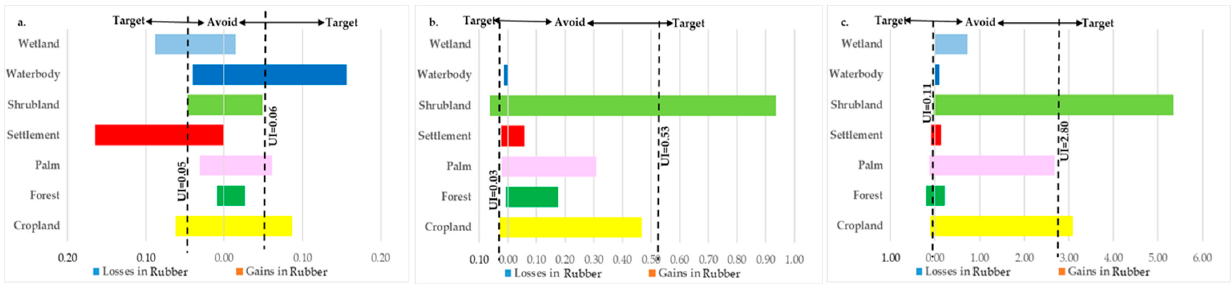
Figure 7. Transition level intensities for rubber for the period ( a ) 1986–2002, ( b ) 2002–2015 and ( c ) 2015–2020 (gains on the right, losses on the left).